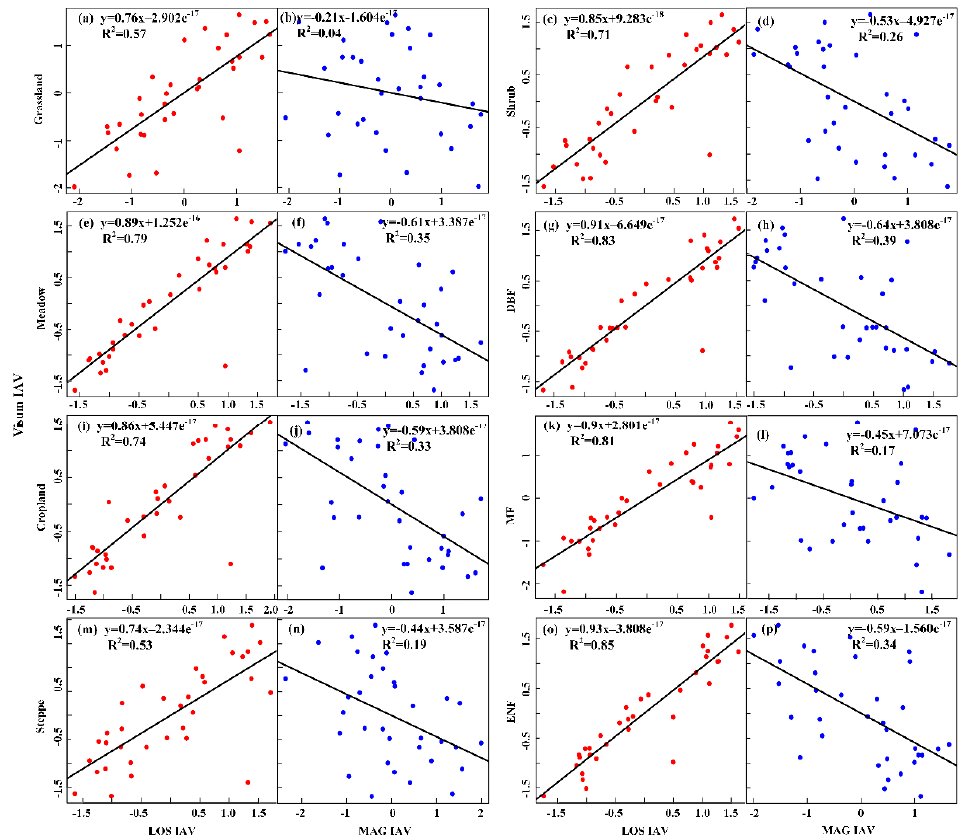
Figure 9. Correlations of VIsum IAV with IAV in LOS and MAG for different vegetation types (rows represent vegetation types, panels with red points denote LOS IAV, panels with blue points denote MAG IAV). ( a , b ) is the correlations in grassland; ( c , d ) in shrubland; ( e , f ) in meadow; ( g , h ) in deciduous broad ‐ leaved forest; ( i , j ) in cropland; ( k , l ) in needle ‐ and broad ‐ leaved mixed forest; ( m , n ) in steppe; ( o , p ) in evergreen needle ‐ leaved forest.